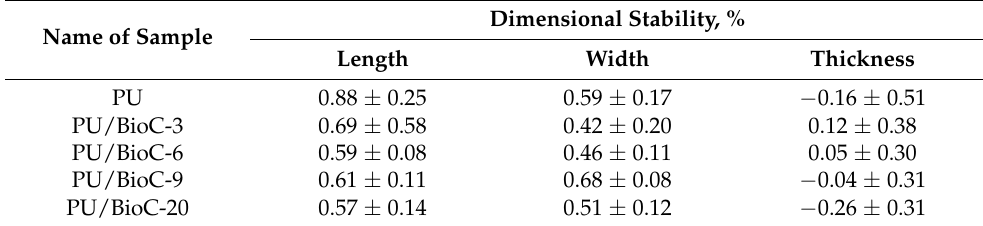
Table 4. Dimensional stability of polyurethane foams.